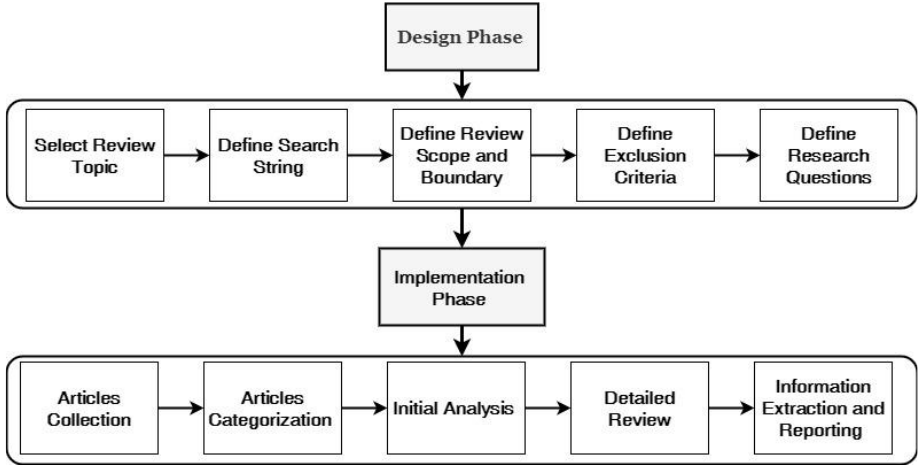
Figure 1. Dual-phase systematic review procedure. The procedures followed at the first stage are part of the design phase.